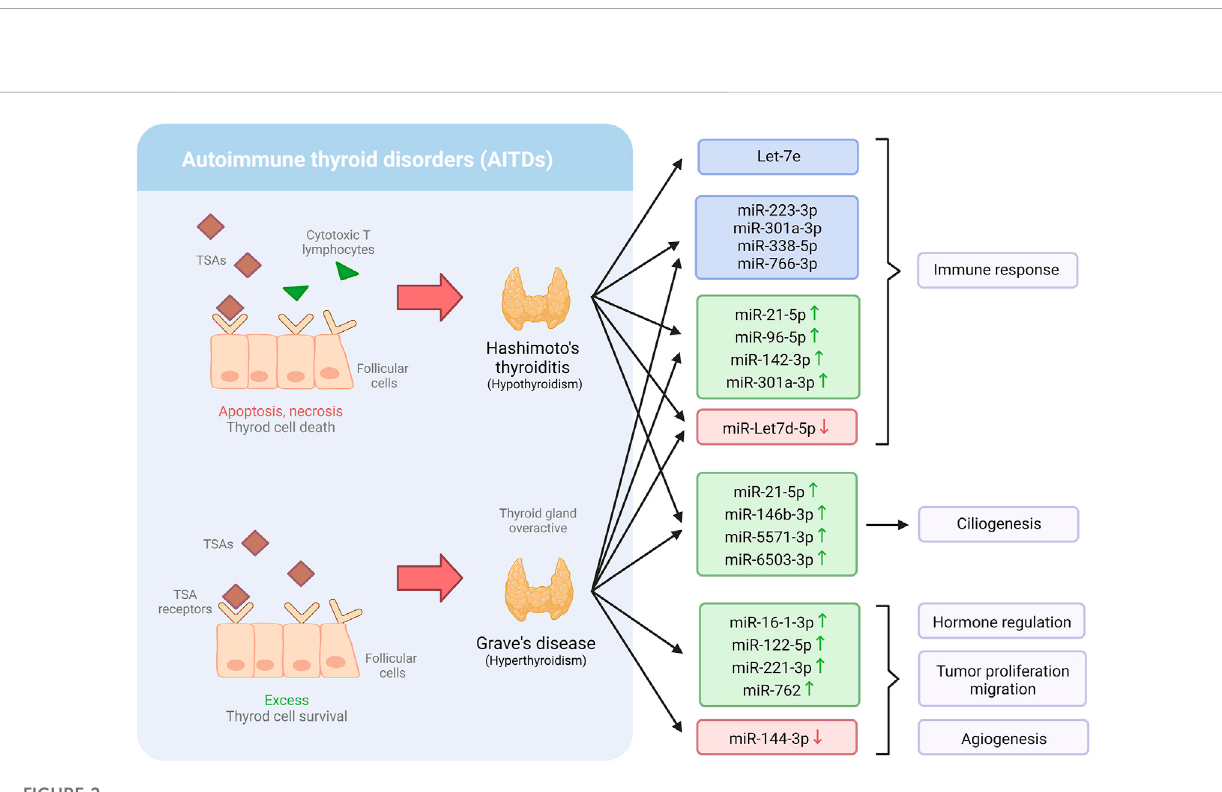
de fi ciency. In contrast, T2D is attributed to a continuous loss of β - cell insulin secretion, often in the context of insulin resistance (Association, 2019). Diabetes prevalence increases yearly, affecting around 500 million people worldwide (Saeedi et al.,